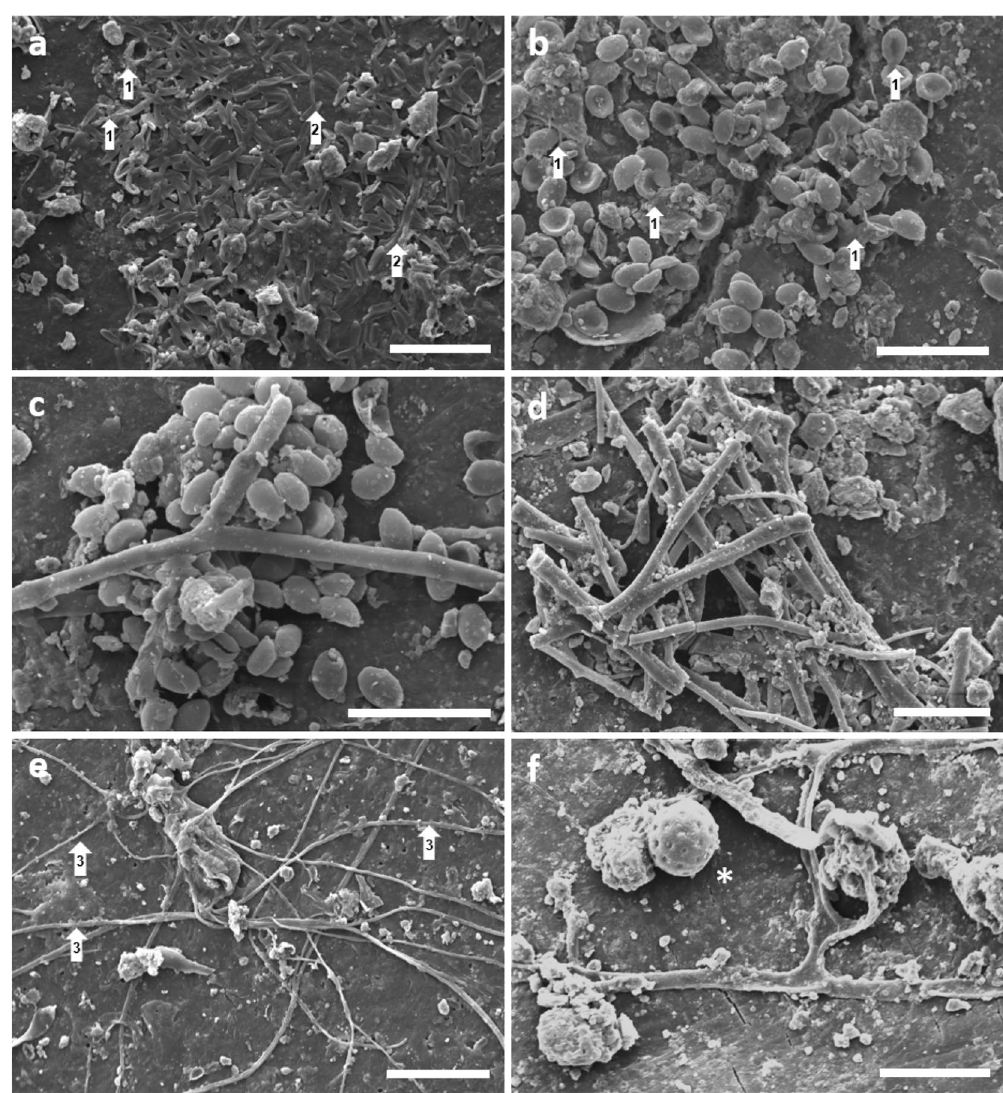
Figure 1. Fungal colonisation of MP fragments visualised by SEM. White arrows indicate specific structures. ( a ) Mat of fungal conidia, including potentially germinating spores (1), closely attached to the plastic surface presumably through a form of self-produced mucilage (2). ( b ) Numerous conidia lining a crack in the plastic surface. ( c ) Clumping of conidia in association with a hypha. ( d ) Mycelial meshwork. ( e ) Extensive intertwined hyphal filaments adhering to the plastic surface via small peripheral bulges (3). ( f ) Conidia-producing hypha (conidiophore) with exposed vesicle after discharge (asterisk). Scale bars are 30